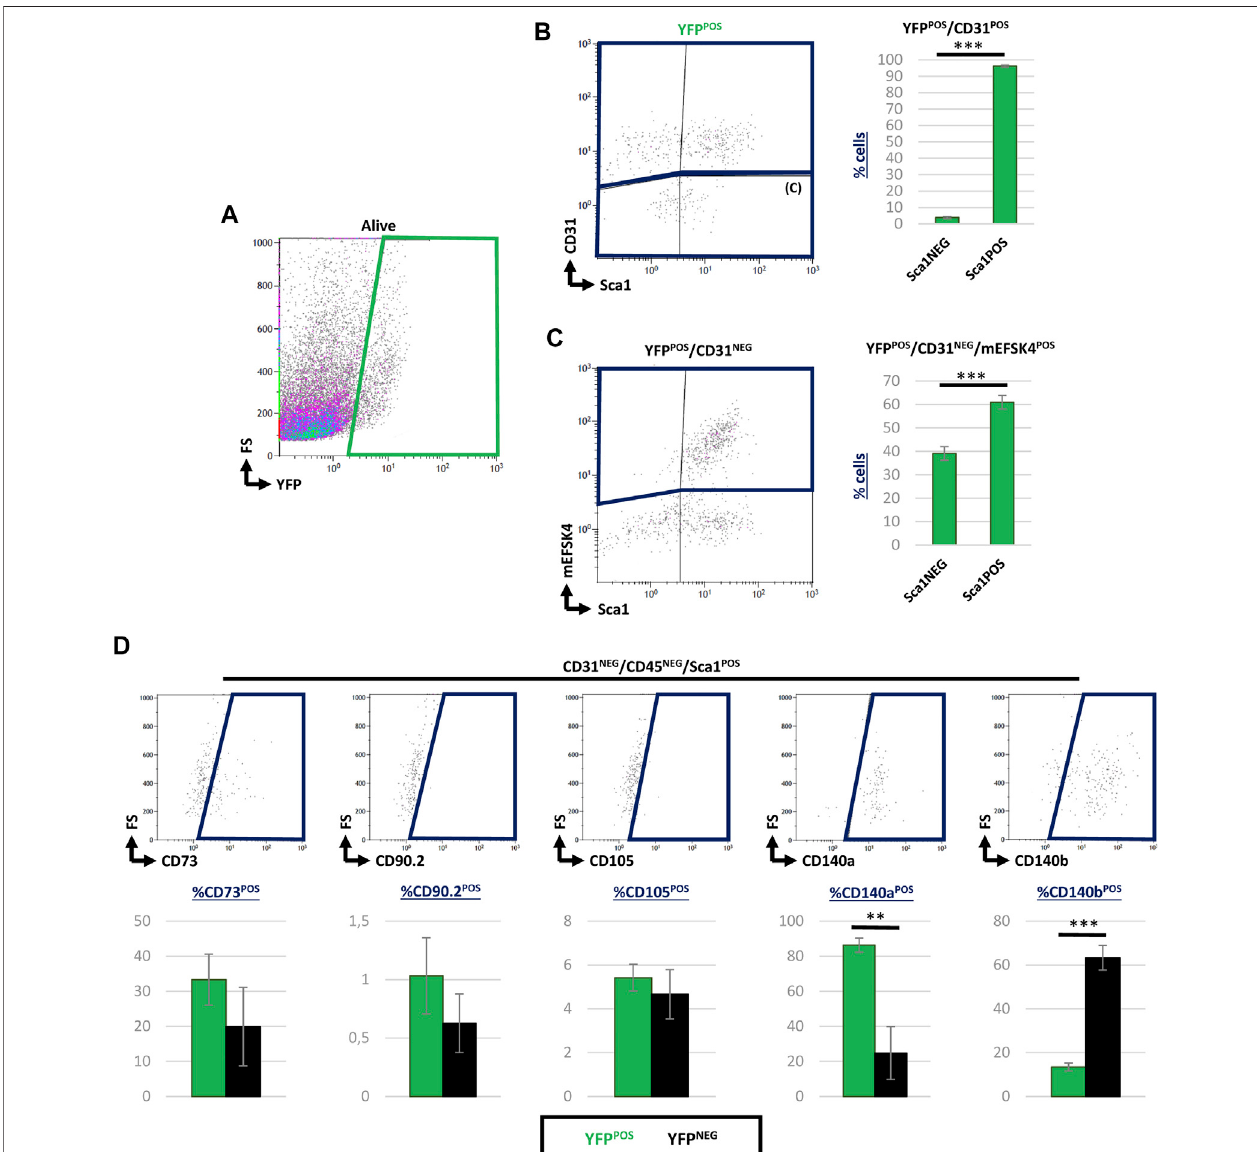
FIGURE 4 | Contribution of Sca1 POS cells into different subpopulations of epicardial-derived cells in the adult heart. (A) Representative dot blots showing the analysisofYFP POS cardiac cells. (B) Dotblot showingCD31 and Sca1 stainingofYFP POS cells(left). Thebar plot represented thepercentagesofSca1 NEG and Sca1 POS cells within the YFP POS /CD31 POS subpopulation (right). (C) Representative dot blots showing the staining of mEFSK4 and Sca1 within the YFP POS /CD31 NEG fraction (left). The bar plot representation of Sca1 NEG and Sca1 POS cells into percentages within the YFP POS /CD31 NEG /mEFSK4 POS cardiac fi broblasts population (right). (D) DotblotssummarizingtheresultsfromCD73,CD90,CD105,CD140a,andCD140bstainingofCD31 NEG /CD45 NEG /Sca1 POS cardiacinterstitialcellsstained.Thebar plot indicates the percentage of these speci fi c subpopulations within the YFP POS (green bars) and YFP NEG (black bars) cell fractions. Abbreviations: CD31/PECAM1, platelet and endothelial cell adhesion molecule 1; CD45, protein tyrosine phosphatase receptor type C; CD73, cluster of differentiation 73; CD90, Thy-1 cell surface antigen;CD105,endoglin;CD140a,platelet-derivedgrowthfactorreceptorA;CD140b,platelet-derivedgrowthfactorreceptorB;Sca1,stemcellantigen-1;YFP,yellow fl uorescent protein. N, 3 biological replicates. ** p -value ≤ 0.01; *** p -value ≤ 0.005.